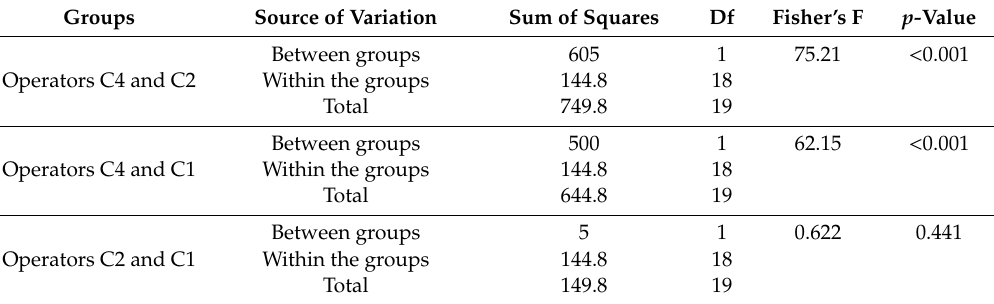
Table 3. Analysis of variance of the resolved FA.